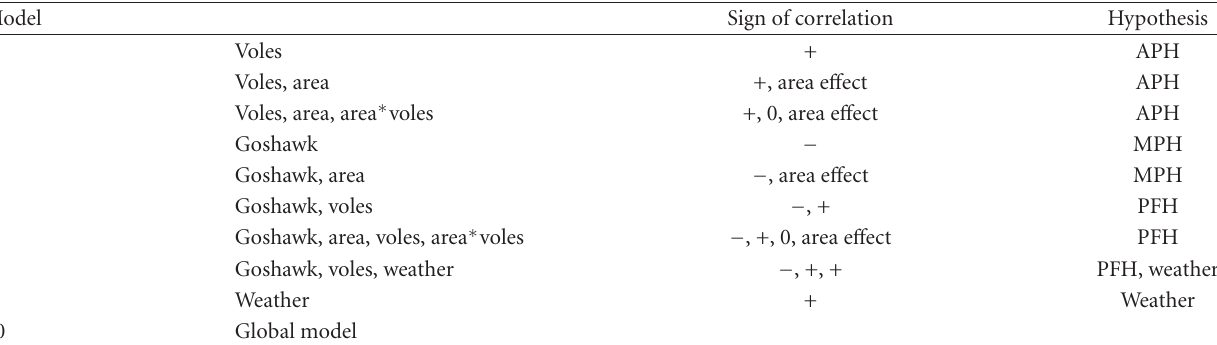
Table 1: Model designs to explain variation in loss of grouse chicks during 2 summer months in study areas of South Ostrobothnia and Oulu in western